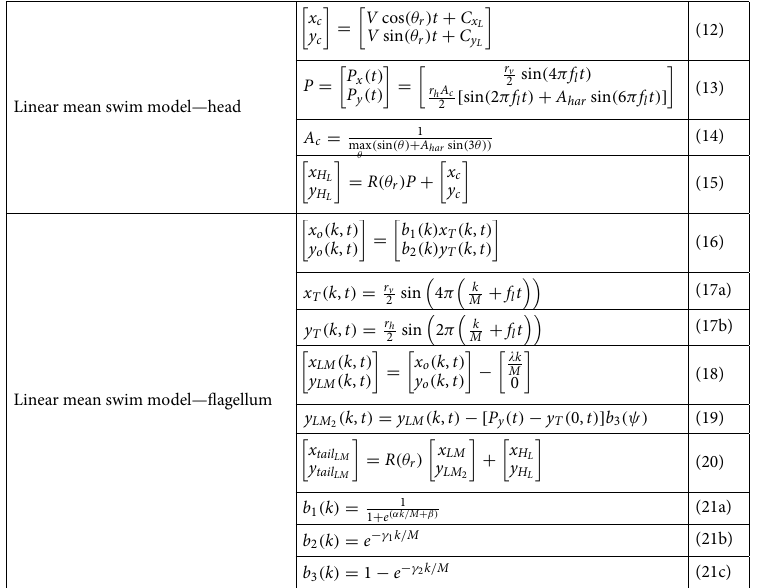
, y Table 2. Simulation of a linear mean swimming cell. ( x H H L ) : position of the sperm head of linear L , C swimming cell . ( C x y L ) : horizontal and vertical offset constant (pixels). V : straight line path velocity L (pixels/sec). f l : rate of change in ribbon angle (Hz). r h , r v : width and height of ribbon (pixels). A har : user defined ratio between the first and the third harmonics. A c : correction constant for defined width of the , y ribbon. θ r : direction of the forward movement (radian). ( x Tail Tail LM ) : a set of k points along the center LM of the flagellum of linear mean swimming cell. b 1 ( k ) , b 2 ( k ) : local horizontal and vertical variation in beating amplitude along the flagellum. b 3 ( k ) : flagellum position correction function.